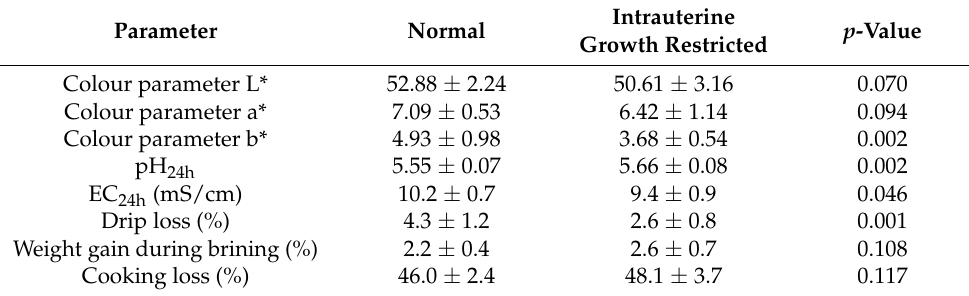
Table 4. Colour parameters and physical analysis of the meat of the normal ( n = 12) and intrauterine growth restricted (IGUR) ( n = 11) pigs. Mean ± SD, Student t